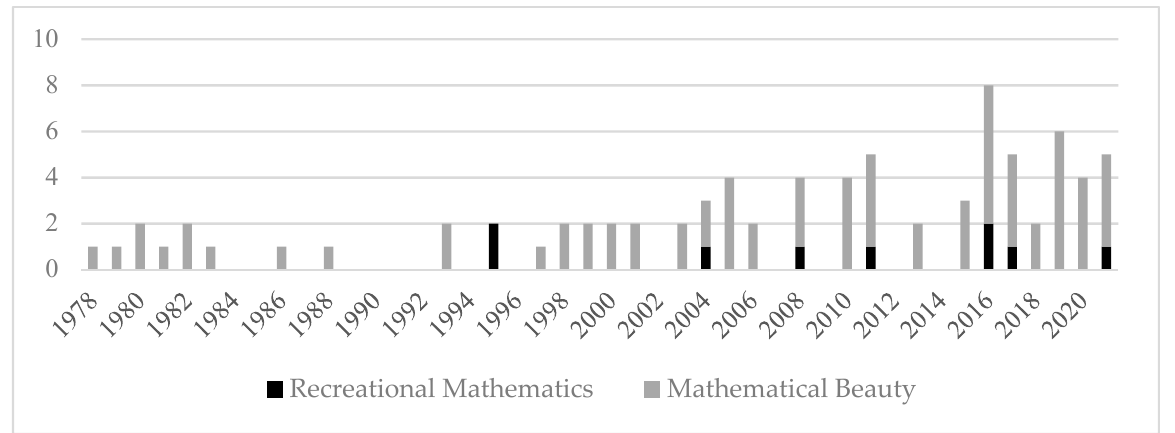
Figure 8. Histogram of the changes in the number of items in different sub-categories of the category of Aesthetics & Recreation .